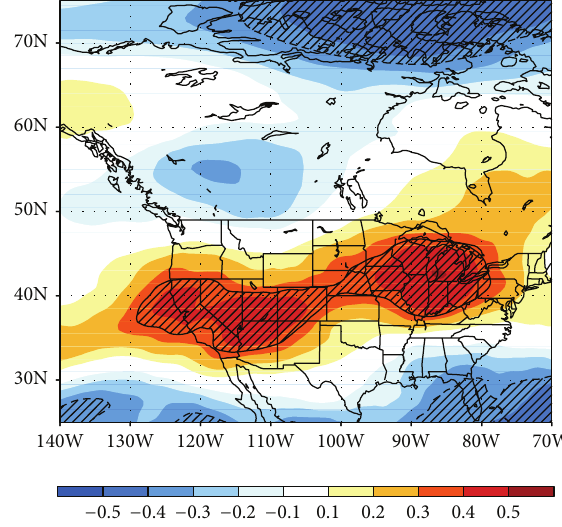
Figure 9: Correlation of storm-rainfall index with 200 hPa zonal wind for JAS. Hatched areas show 95%